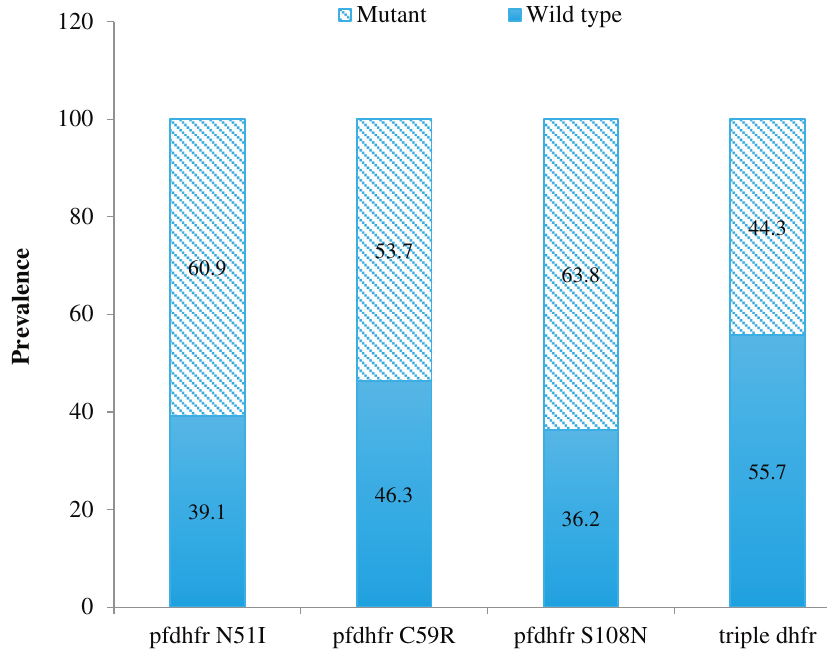
Figure 1. Prevalence of pfdhfr and pfdhps